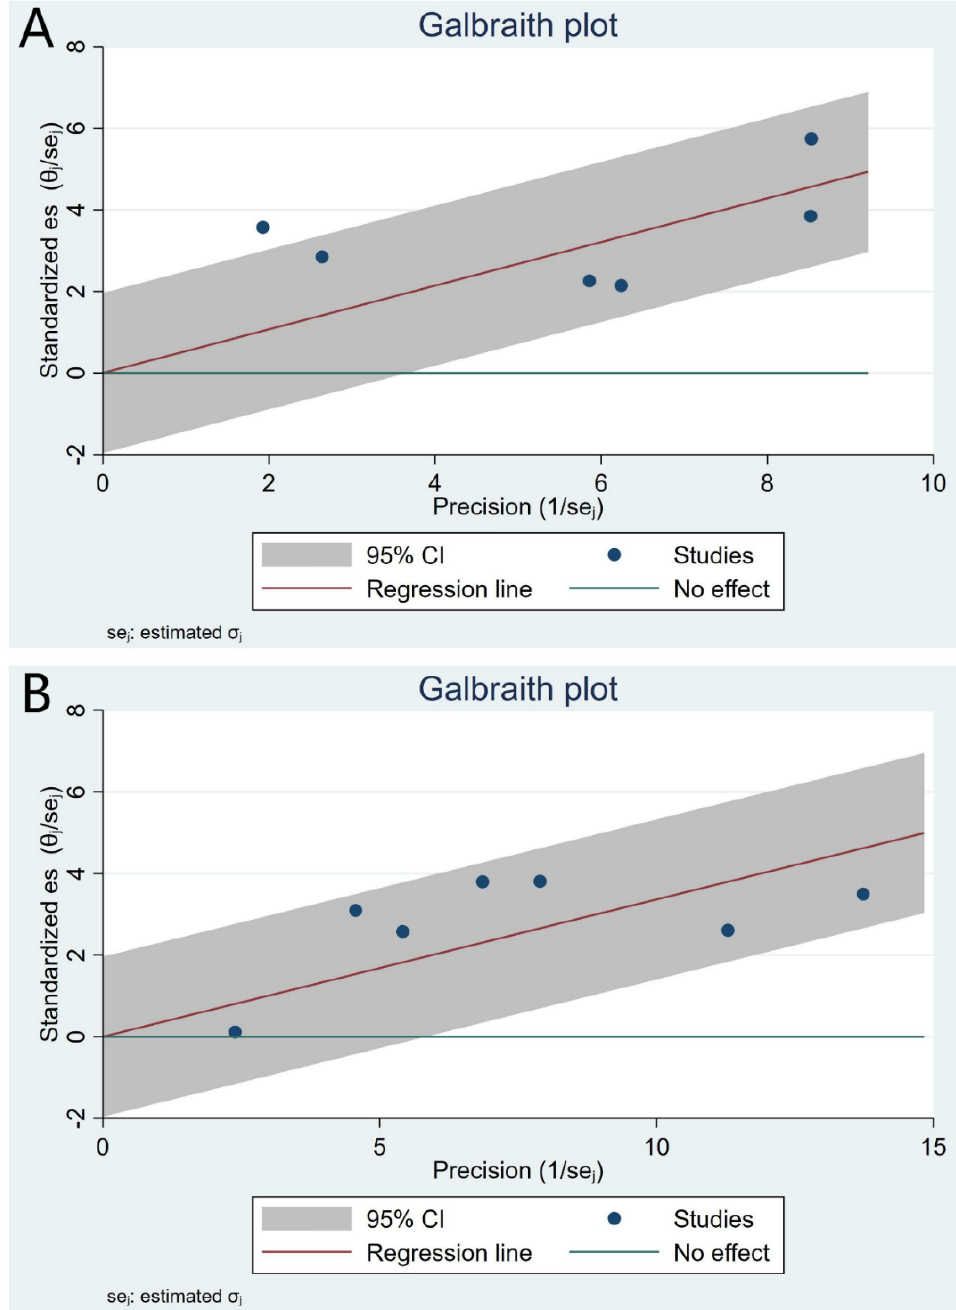
Figure 3. Galbraith plots for heterogeneity test of the meta-analysis. ( A ) The RLP-C analyzed as a categorical variable. ( B ) The RLP-C analyzed as a continuous variable.